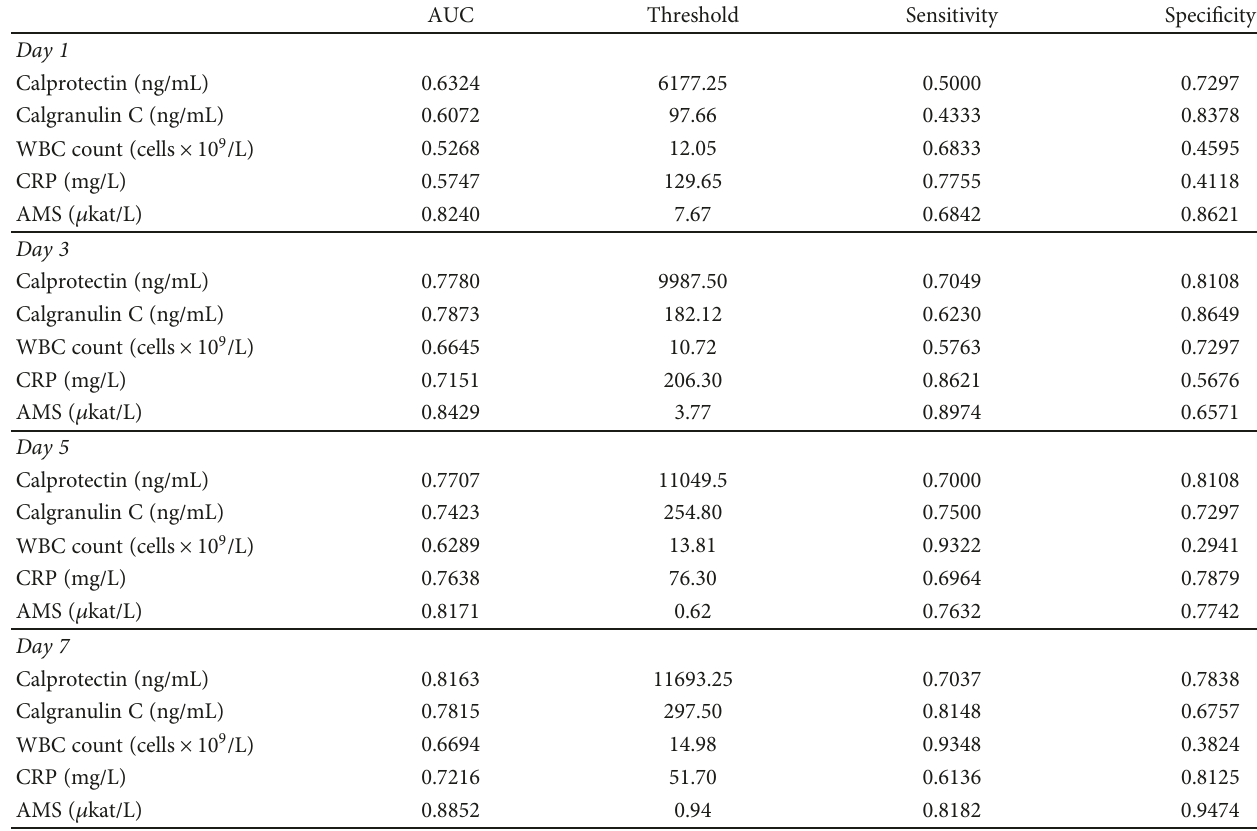
Table 4: AUCs, cuto ff values, sensitivities, and speci fi cities of the biomarkers for the prediction of surgical complications.